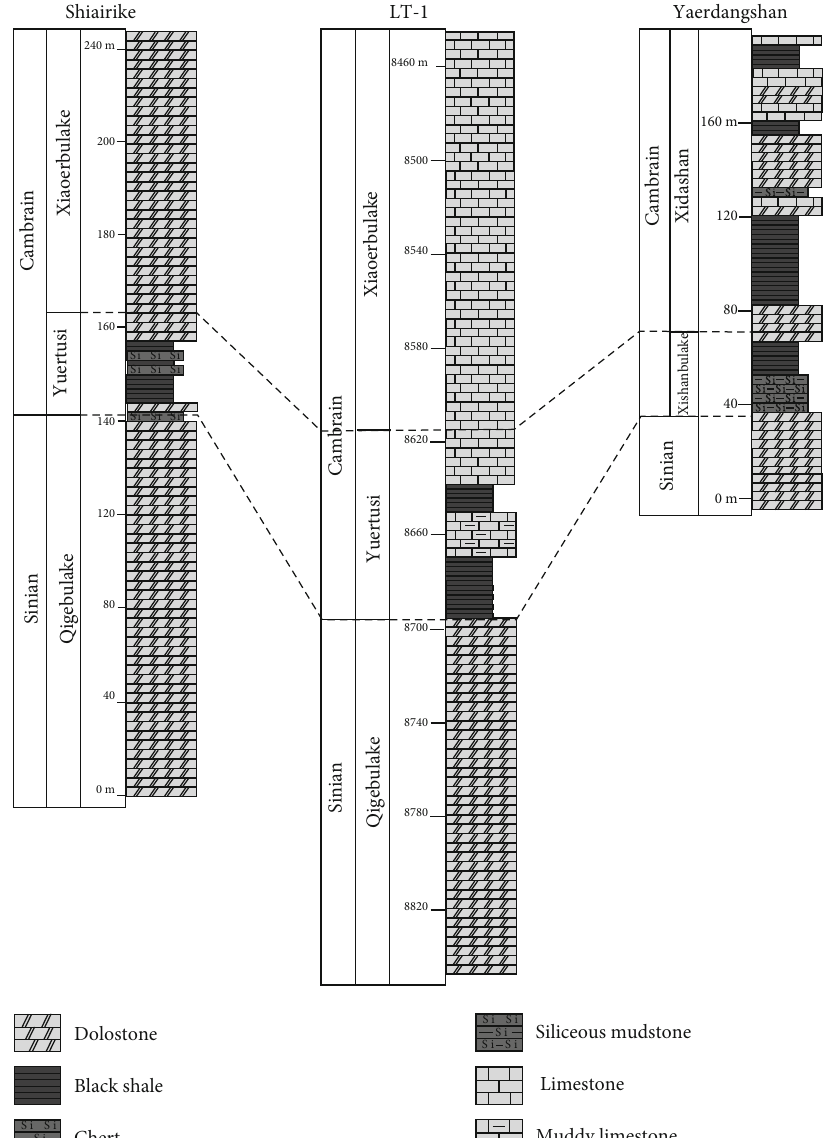
Figure 2: Stratigraphic correlations of Sinian-Lower Cambrian between well Luntan 1 [14], the Shiairike [19], and Yaerdangshan sections